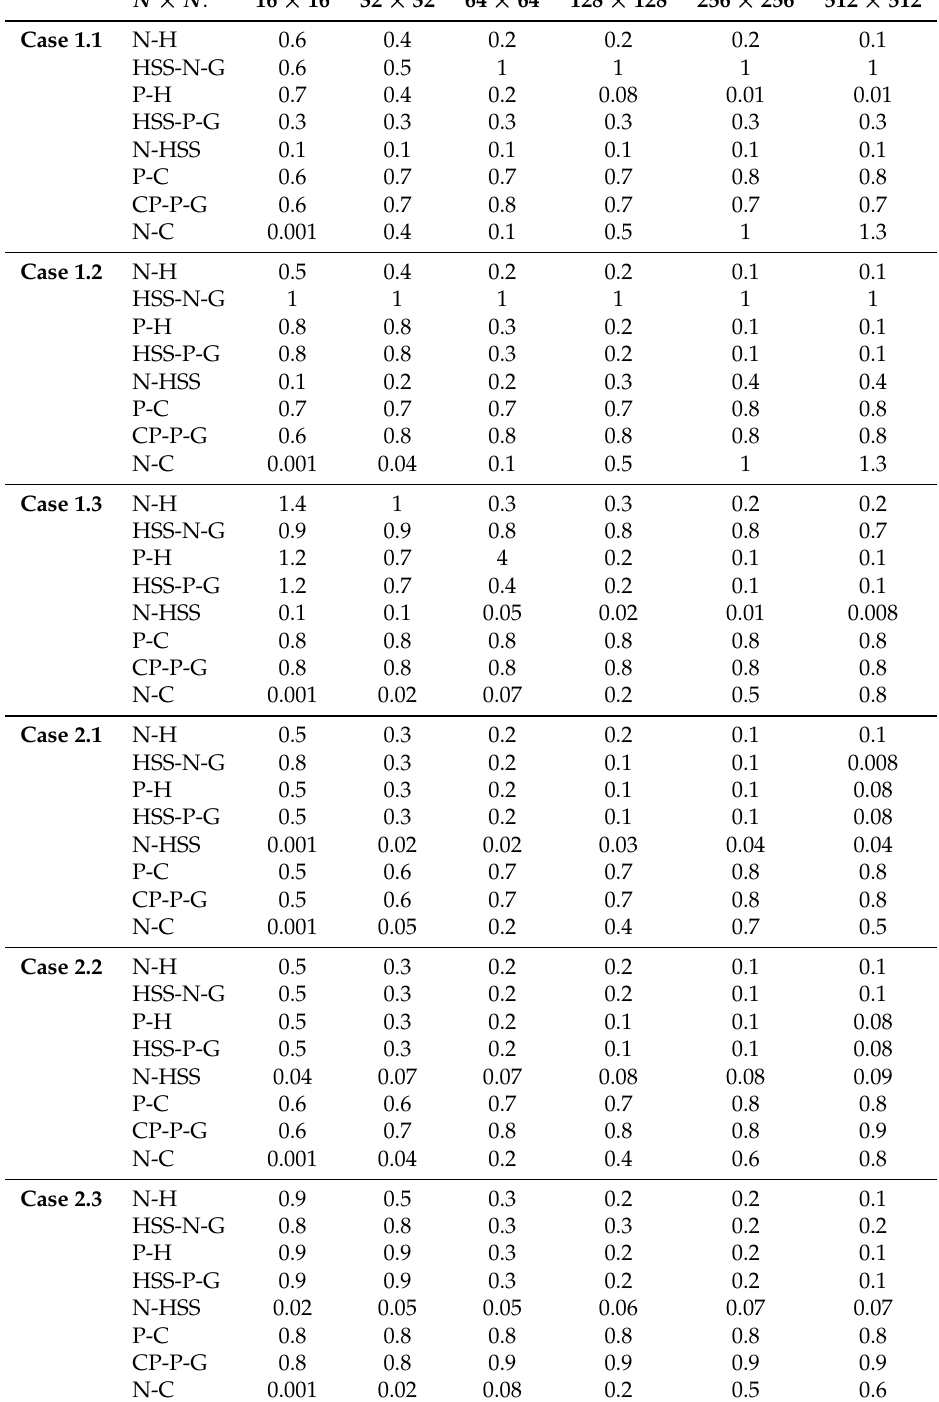
Table 3. The experimental optimal parameters with respect to different cases and mesh